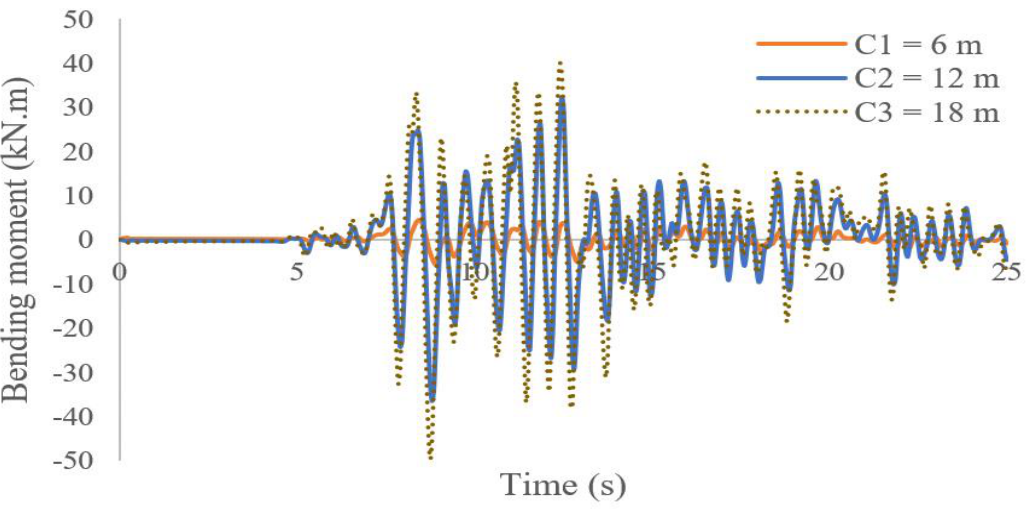
Figure 11. Bending moment created at a node on the tunnel lining.